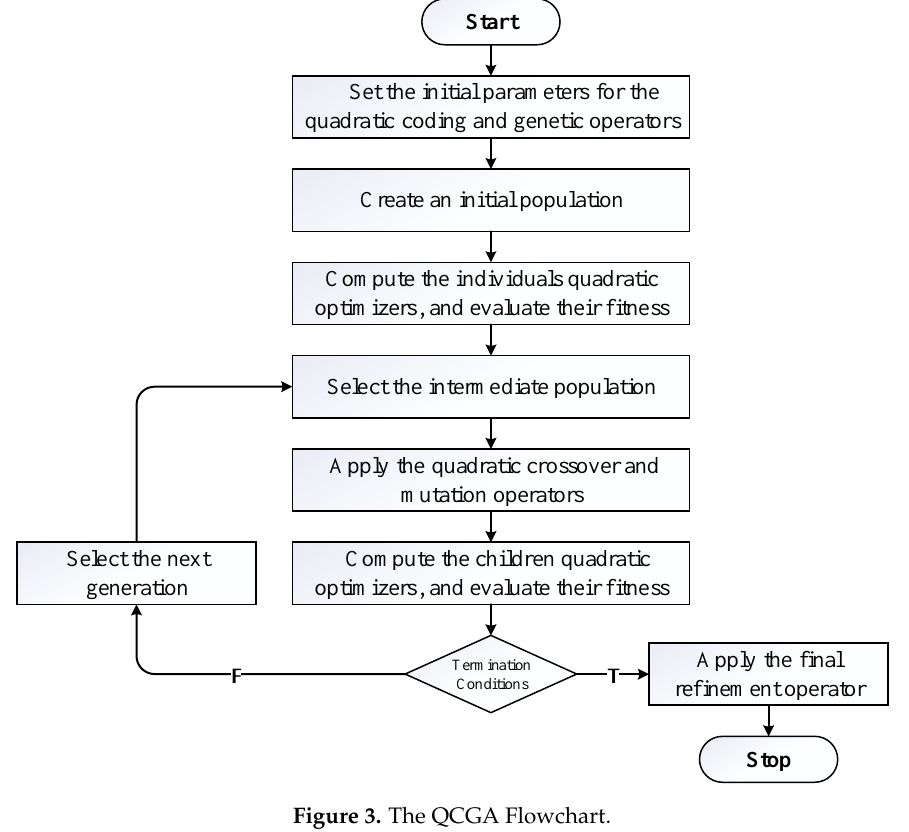
Figure 3. The QCGA